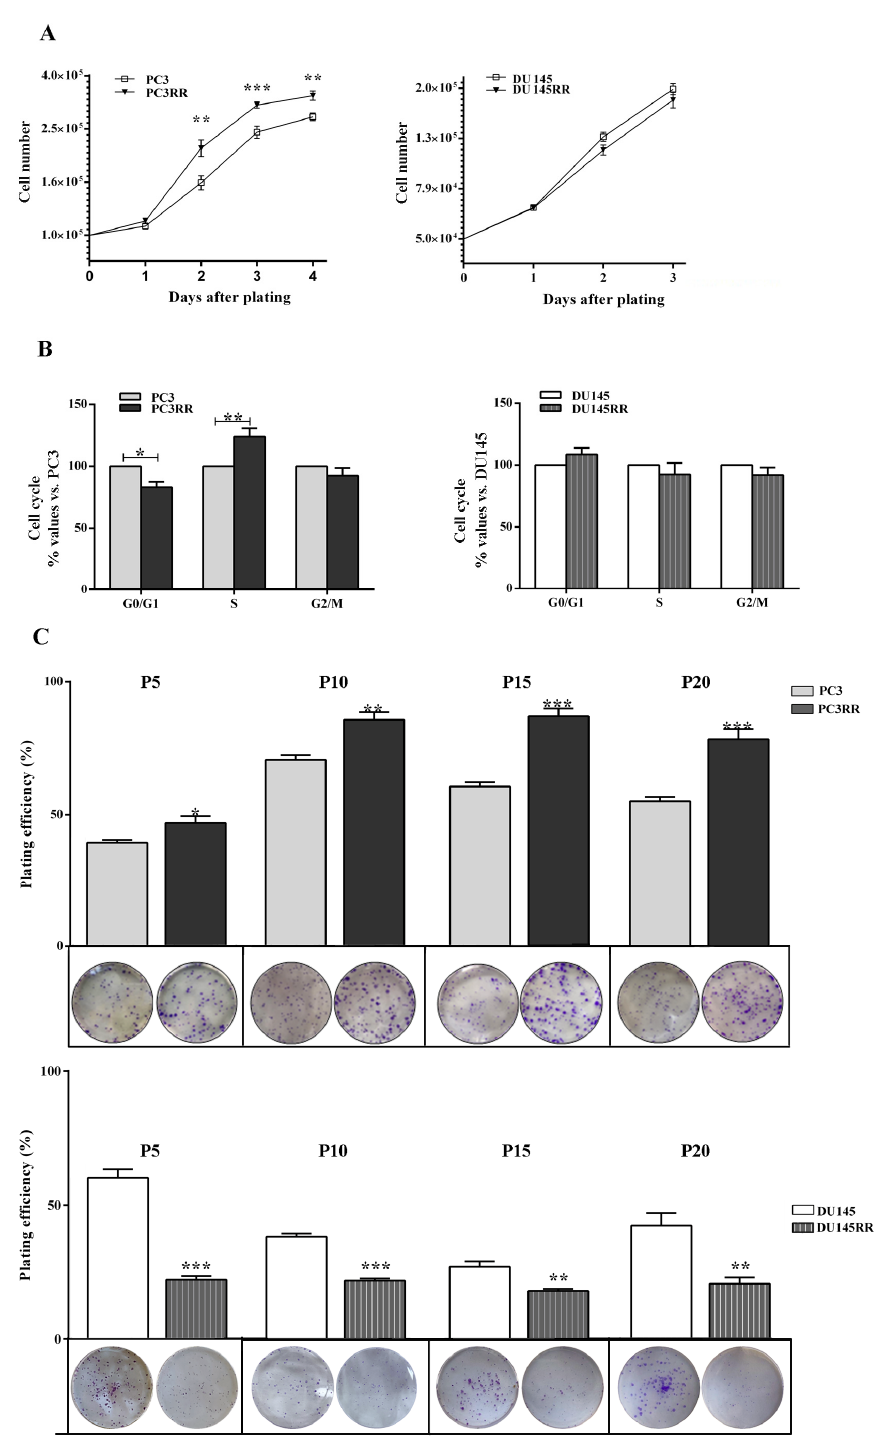
Figure 5. Characterization of proliferation and clonogenic potential of PCaRR cell lines. ( A ) Proliferation and ( B ) cell cycle distribution at 24 h after plating of both cell lines. ( C ) Plating efficiency (PE) is the ratio of the number of colonies to the number of cells seeded x 100. Under each col- umn, the representative micrographs of clones plated at 200 cells/well produced by PC3, PC3RR, DU-145 and DU-145RR cells at different passages (P) from P5 to P20 are shown. Data represent the mean values ± S.E.M. derived from at least three independent experiments. * p < 0.05; ** p < 0.01; *** p < 0.001; PC3RR vs. PC3 and DU-145RR vs. DU-145 Student’s unpaired t